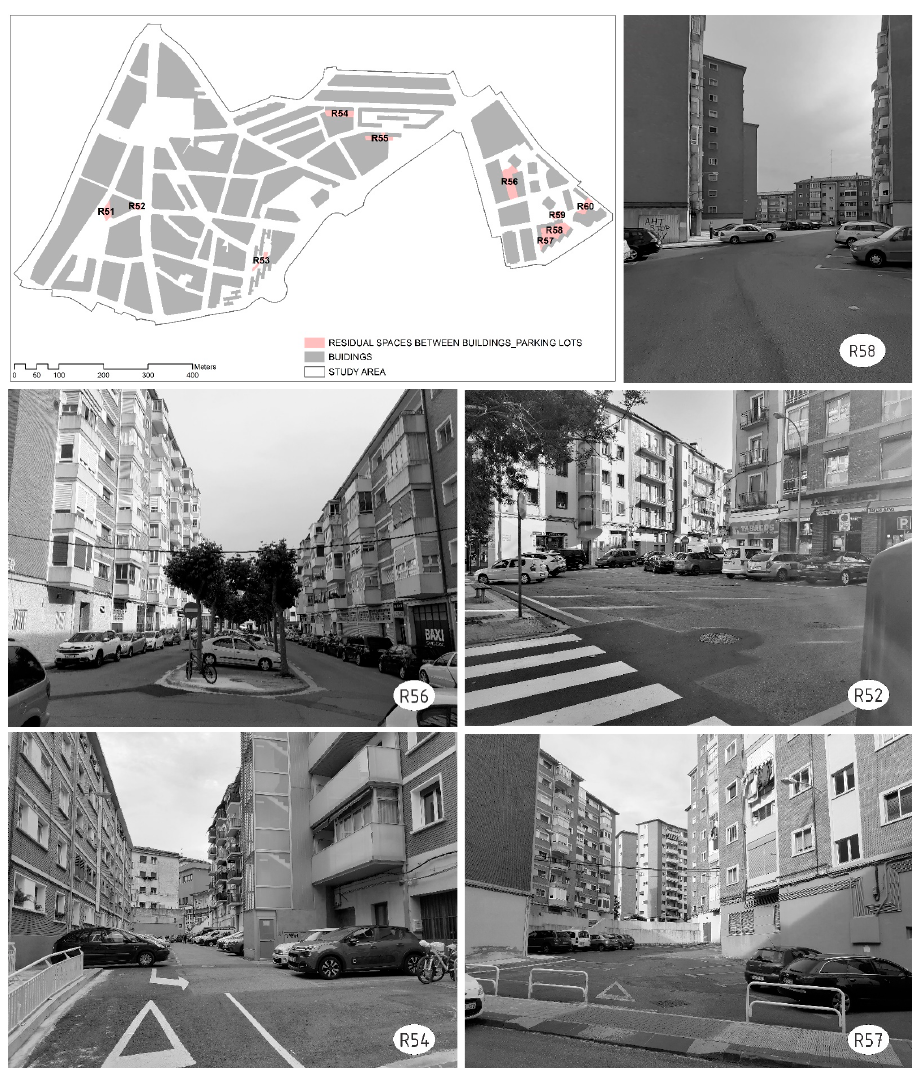
Figure 17. Residual spaces between buildings: car parks.